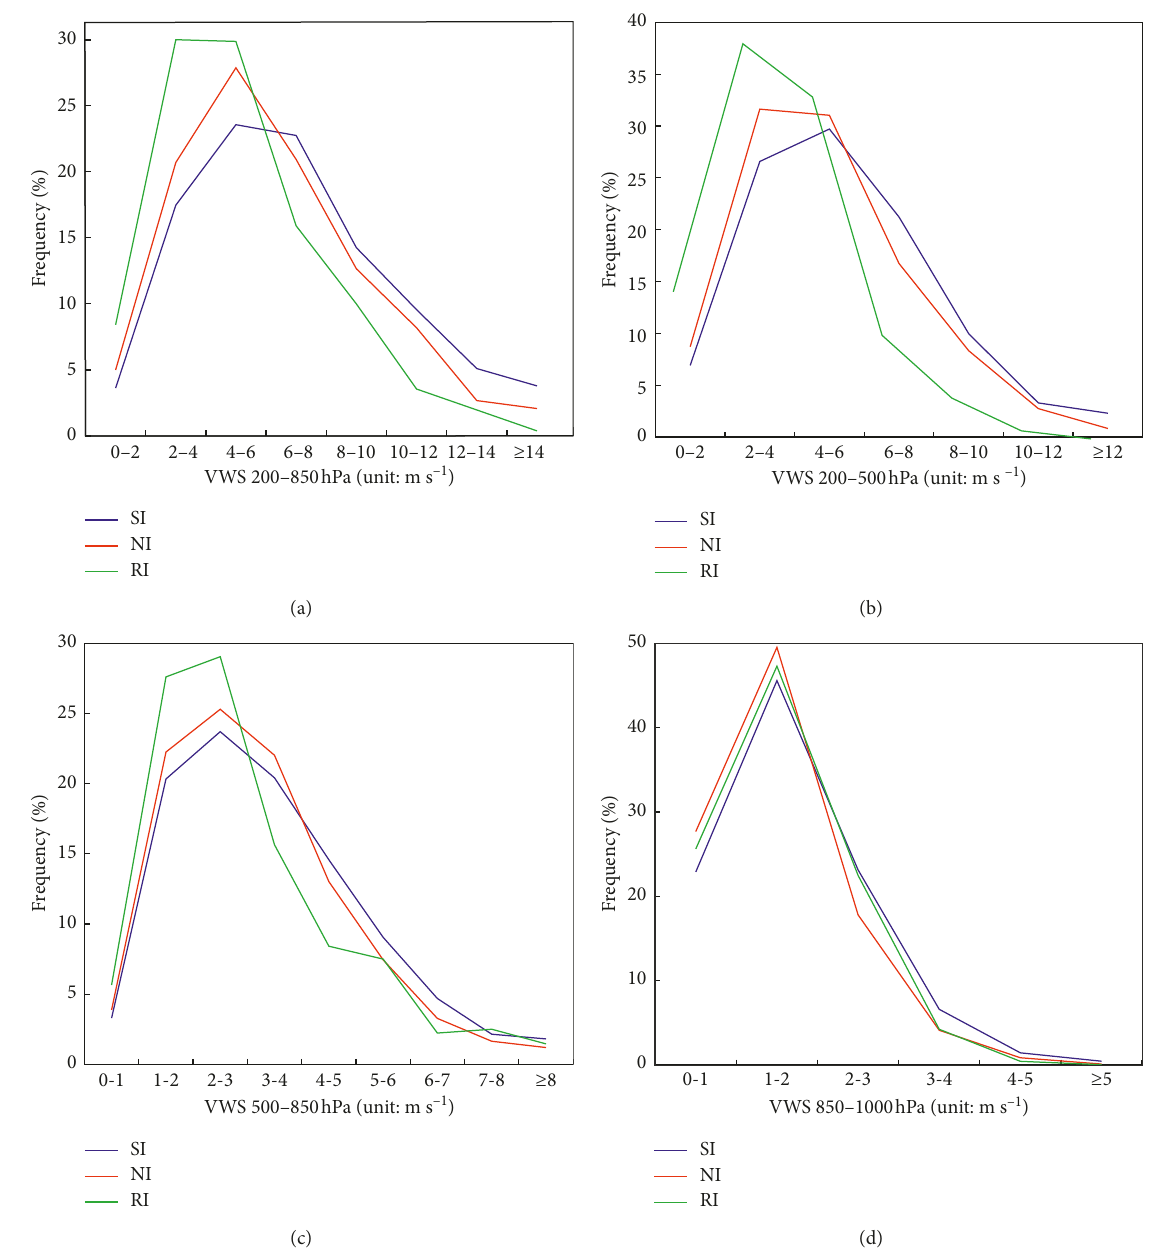
Figure 8: The frequency distribution of the three intensification categories (RI, NI, and SI) as a function of vertical wind shear (VWS, m s − 1 ): (a) deep-layer shear VWS , (b) upper-mid shear VWS , (c) mid-low shear VWS , (d) low-level shear VWS 200 − 850 200 − 500 500 − 850 850 − 1000